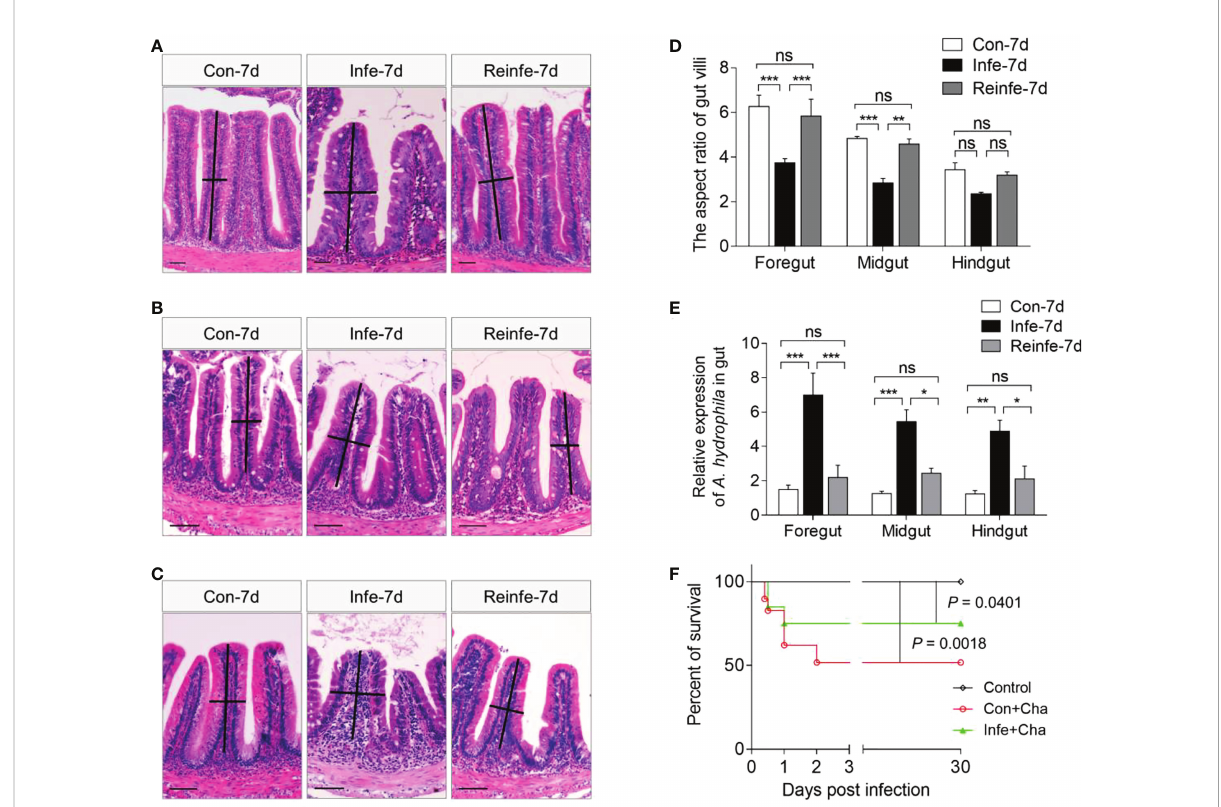
FIGURE 6 Histological examination, bacterial loads, and survival rates of common carp after rechallenging with A. hydrophila . (A – C) Histological examination by H&E staining of foregut (A) , midgut (B) , and hindgut (C) from Control (Con-7d), Con+Cha (Infe-7d), and Infe+Cha (Reinfe-7d) groups of fi sh. (D) The length-width ratio of foregut, midgut, and hindgut intestinal folds from (A – C) . (E) The expression levels of A. hydrophila in control, infected-7d, and reinfected-7d fi sh were measured in the gut of common carp ( n = 6). (F) Cumulative survival of control, infected, and reinfected fi sh. Statistical differences were evaluated by log-rank (Mantel-Cox) test. ns, not signi fi cant, * P < 0.05, ** P < 0.01, and *** P < 0.001 (one-way ANOVA with Bonferroni correction). Data are representative of at least three independent experiments (mean ±